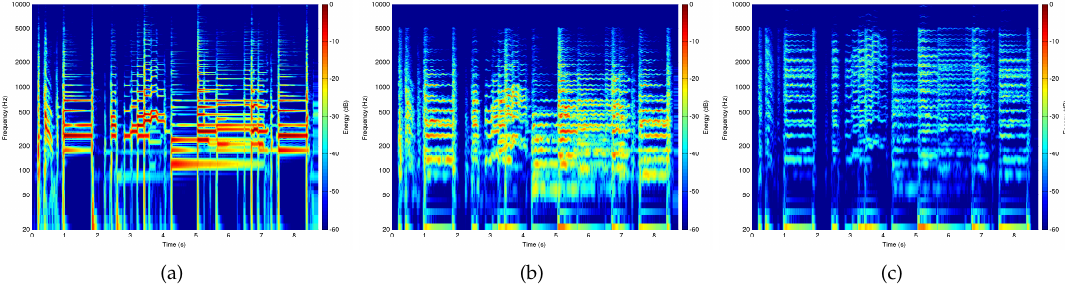
Figure 15. Blues guitar lick, original and two different Hammondized settings. ( a ) Input signal; ( b ) Hammondized, “Jimmy Smith” registration; ( c ) Hammondized, “all out” registration.